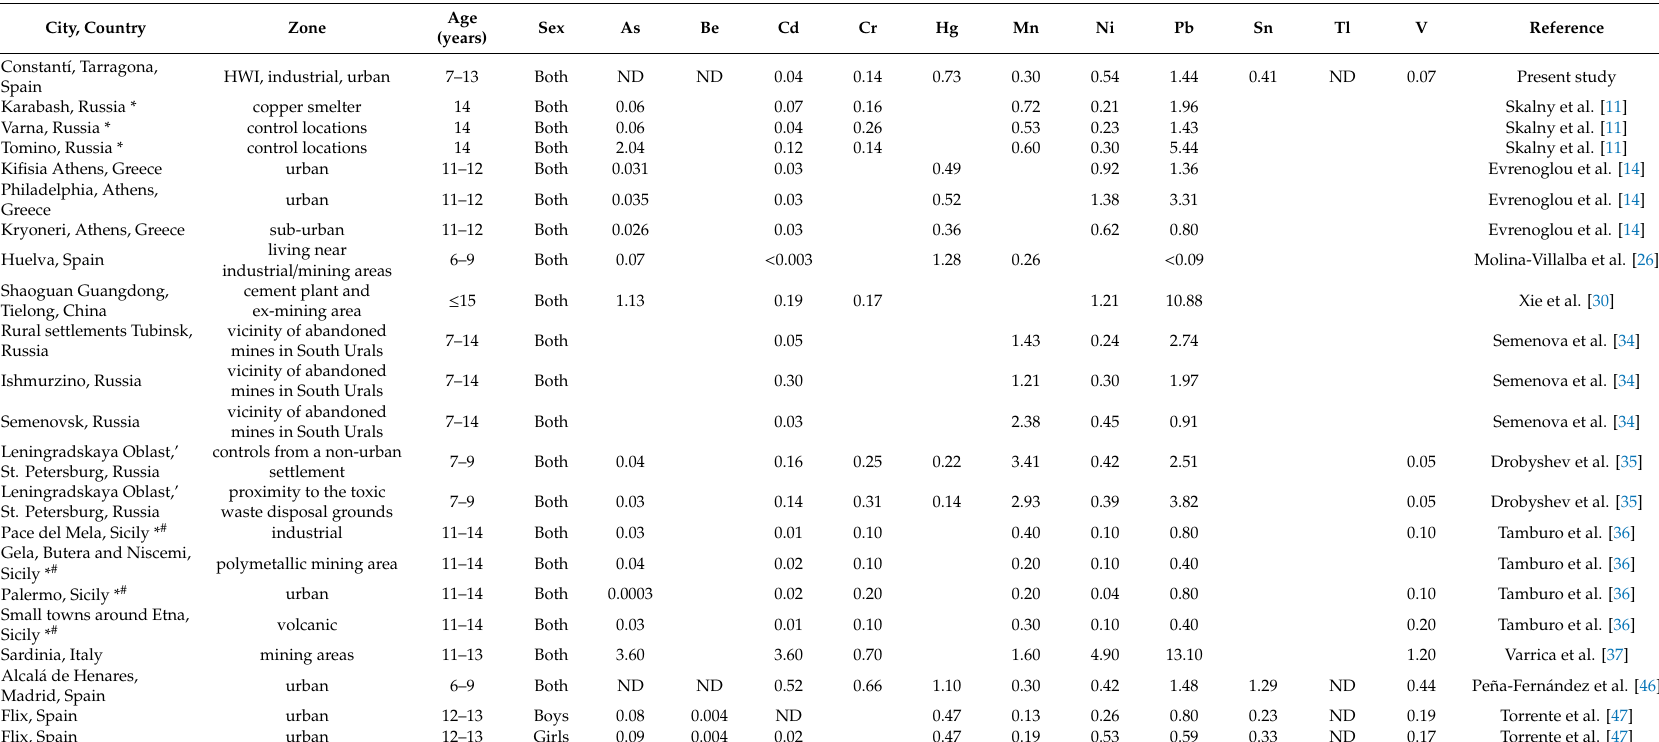
Table 5. Summary of recently published metal concentrations ( µ g / g) in hair of children in di ff erent